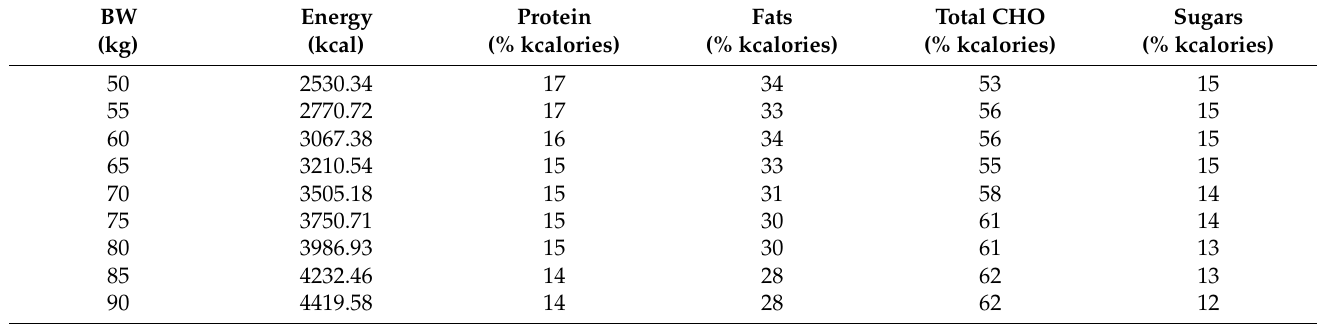
Table 5. Percentage calorie contribution of macronutrients to total calories in the VegPlate for Sports.